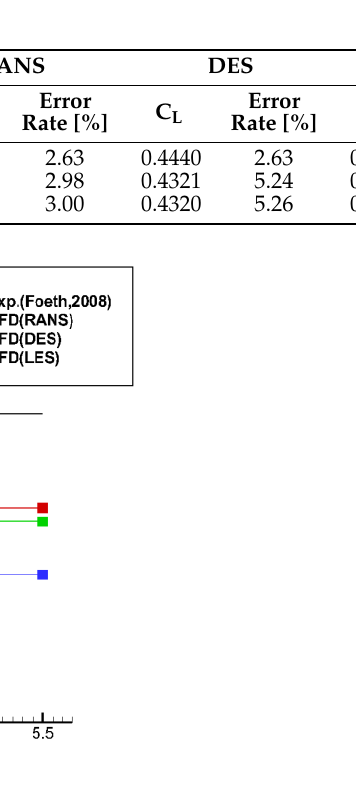
Figure 2. Lift coefficient according to the number of grids.